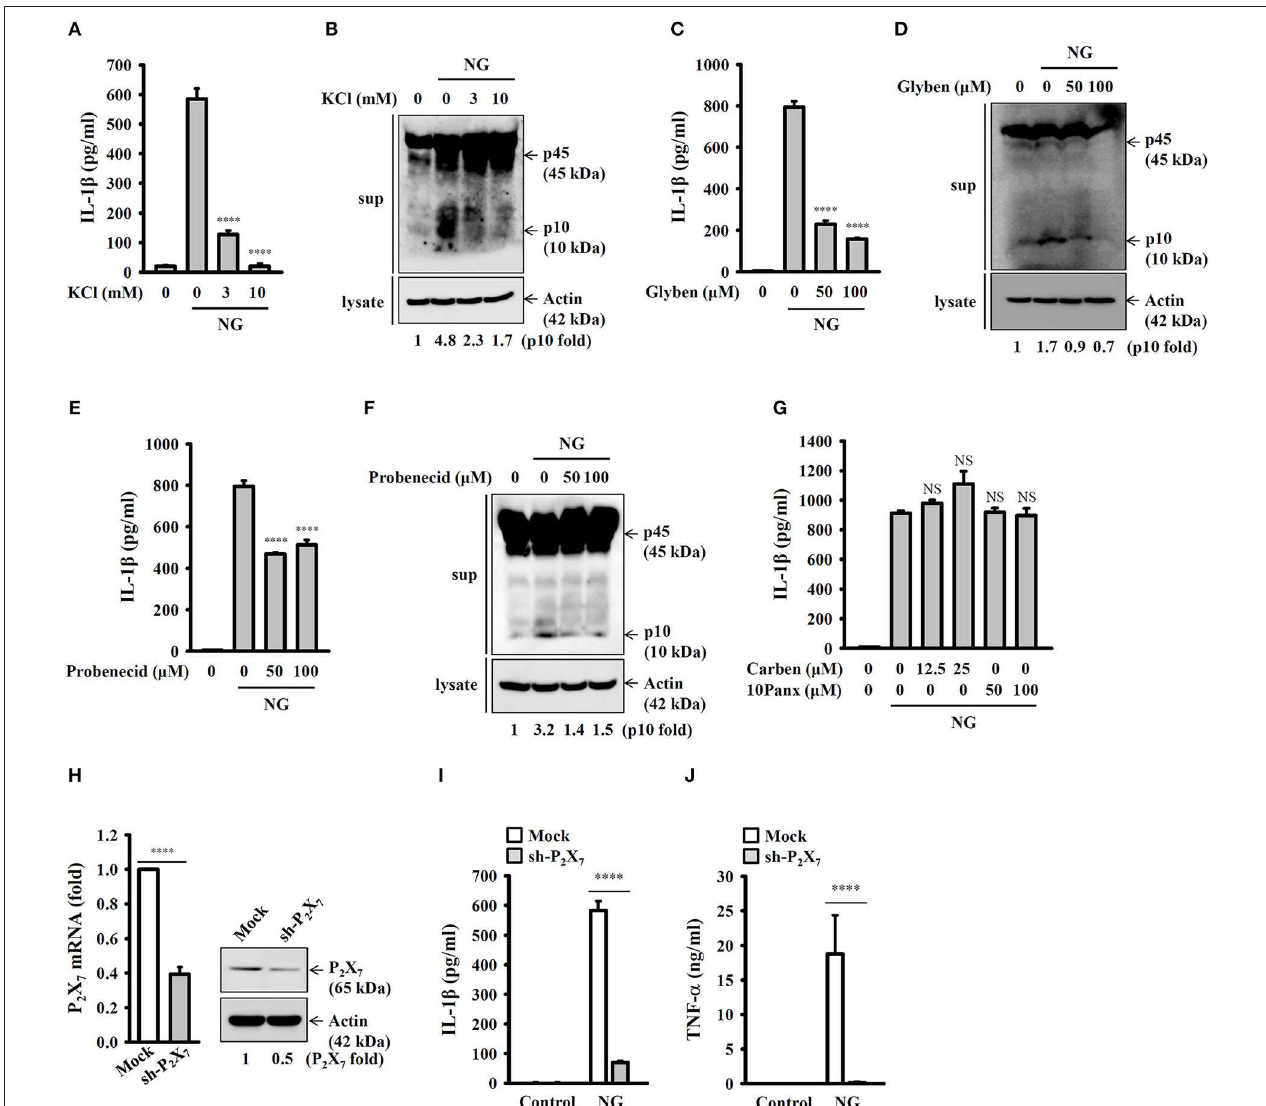
FIGURE 7 | Activation of the NLRP3 inflammasome by NG through P 2 X 7 receptor-mediated K + efflux. J774A.1 macrophages were incubated for 0.5h with KCl (A,B) , glybenclamide (Glyben) (C,D) , probenecid (E,F) , or carbenoxolone (Carben) and 10Panx (G) , followed by infection for 24h with NG at 50 MOI. The levels of IL-1 β in the supernatants were measured by ELISA, and the levels of p45/p10 in the supernatants were measured by Western blotting analysis. (H) The mRNA and protein expression levels of P 2 X 7 in wild-type (mock) or P 2 X 7 -knockdown (sh-P 2 X 7 ) J774A.1 macrophages were measured by RT real-time PCR and Western blotting, respectively. (I,J) Mock or sh-P 2 X 7 cells were infected for 24h with NG at 50 MOI. The levels of IL-1 β (I) and TNF- α (J) in the supernatants were measured by ELISA. The ELISA data are expressed as the mean ± SD of three separate experiments. The Western blotting results are representative of three different experiments, and the band intensity was analyzed by ImageJ and expressed as the fold change compared with the mock control group normalized to actin. A significant difference at the level of **** p < 0.0001 compared to NG-infected cells (A,C,E) or as indicated (H–J) . NS, not significant [One-way ANOVA with Dunnett’s multiple comparisons test in (A,C,E) ; two-tailed t -test in (H–J)